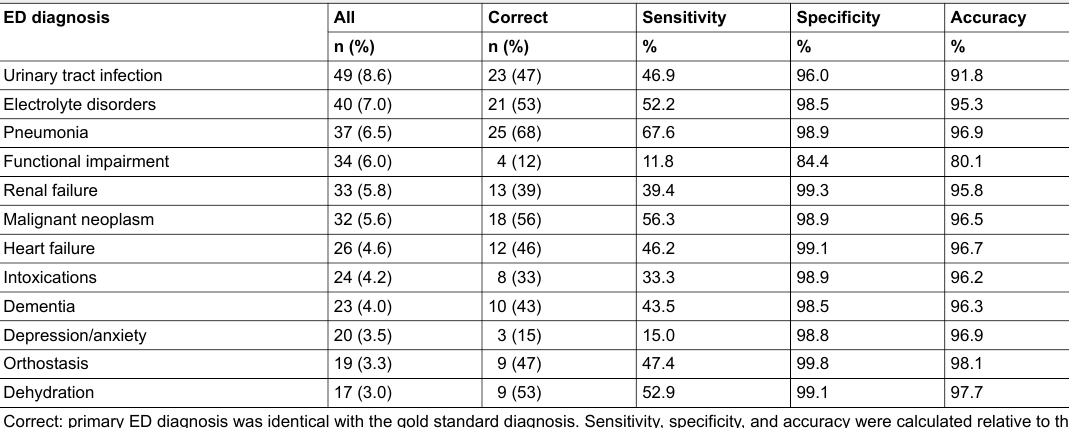
Table 2: Twelve most frequent emergency department (ED) diagnoses. All